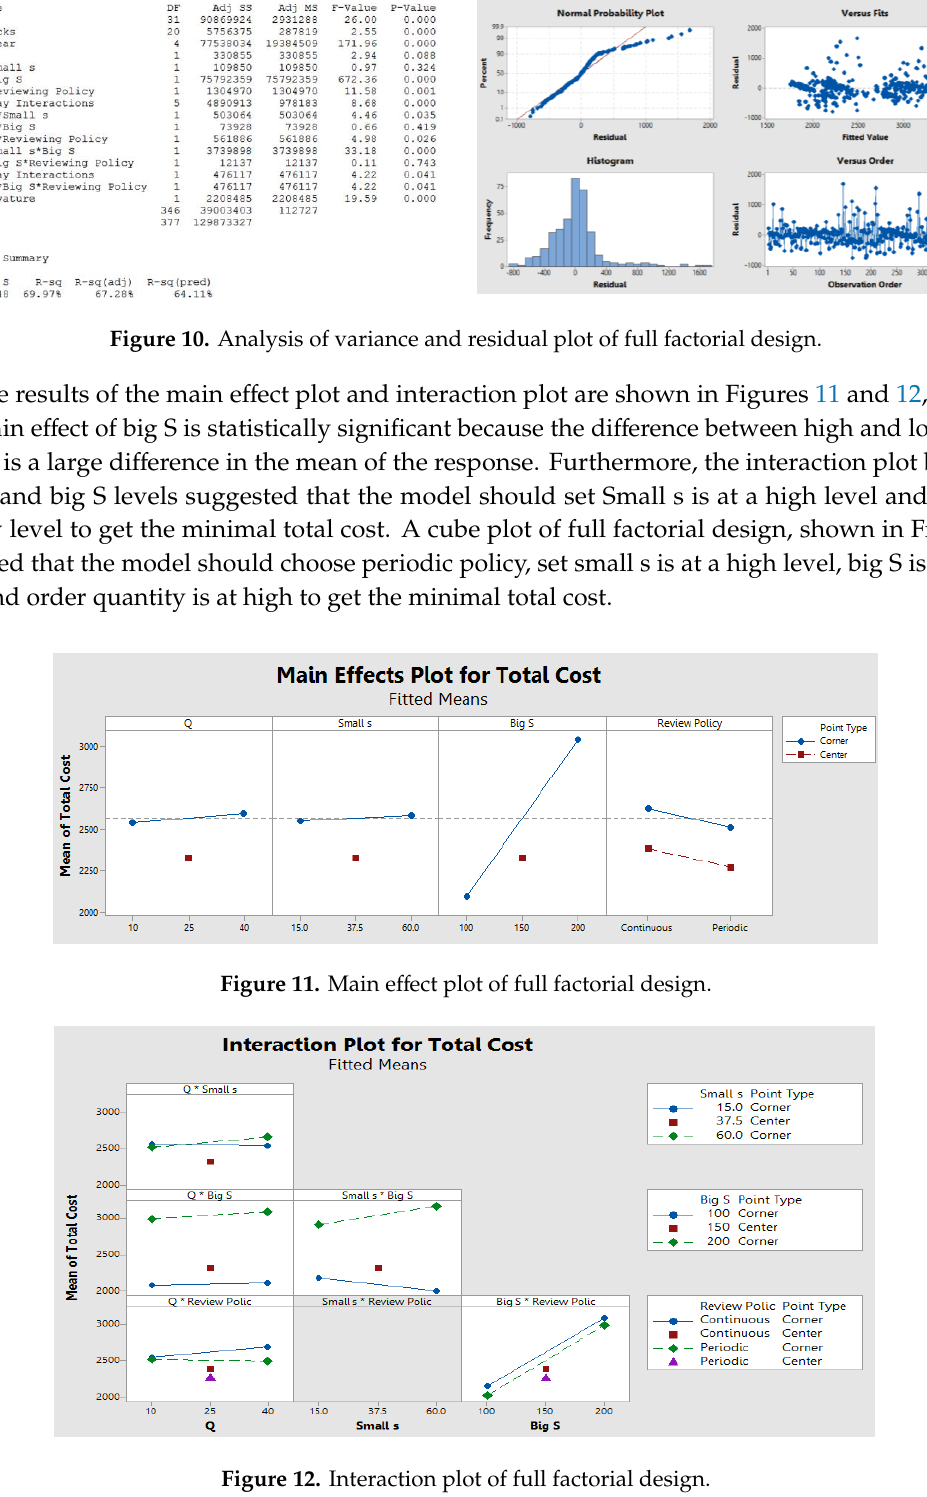
Figure 13. Cube plot of full factorial design.